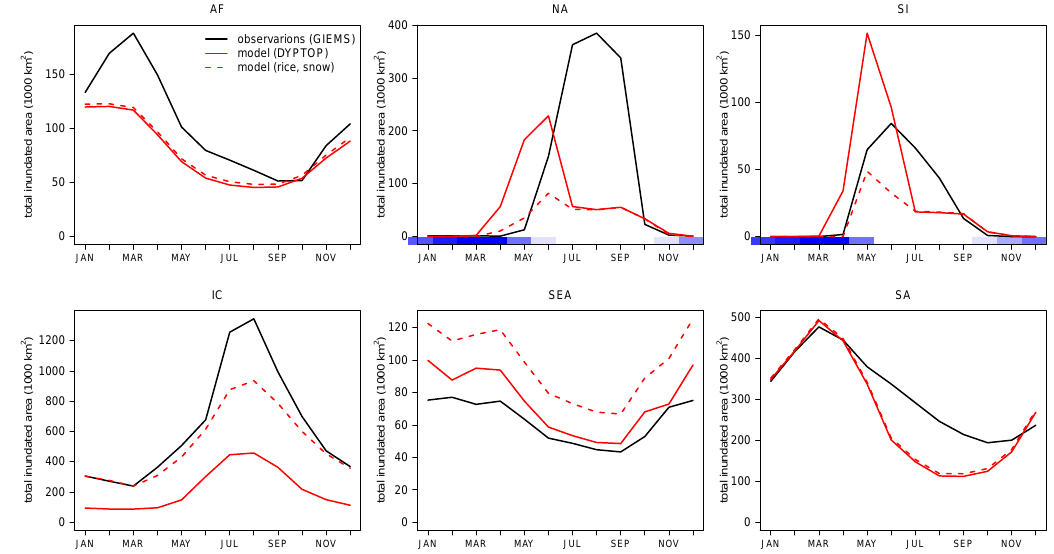
Figure 6. Observed and simulated mean seasonality (mean over 1993–2004, based on simulation S1) of total inundated area by region (AF – Africa, NA – North America, SI – Siberia, IC – India/China and others, SEA – South East Asian Islands, SA – South America). Outlines of these regions are given by the boxes in Fig. 5, bottom. Blue bars in plots for NA and SI represent simulated snow cover as a fraction of annual maximum (blue = 1, white = 0). The fraction of simulated established peatlands (see Fig. 7) is subtracted from the simulated inundation area fraction for a better comparison with GIEMS. Dashed red lines represent simulated inundation additionally corrected for snow cover (areas with with snow cover depth > 30mm snow water equivalents are masked out) and rice cultivation areas (using the maximum of simulation inundation and wet rice cultivation area after Leff et al. (2004) with f = max (f rice ,f ) ).